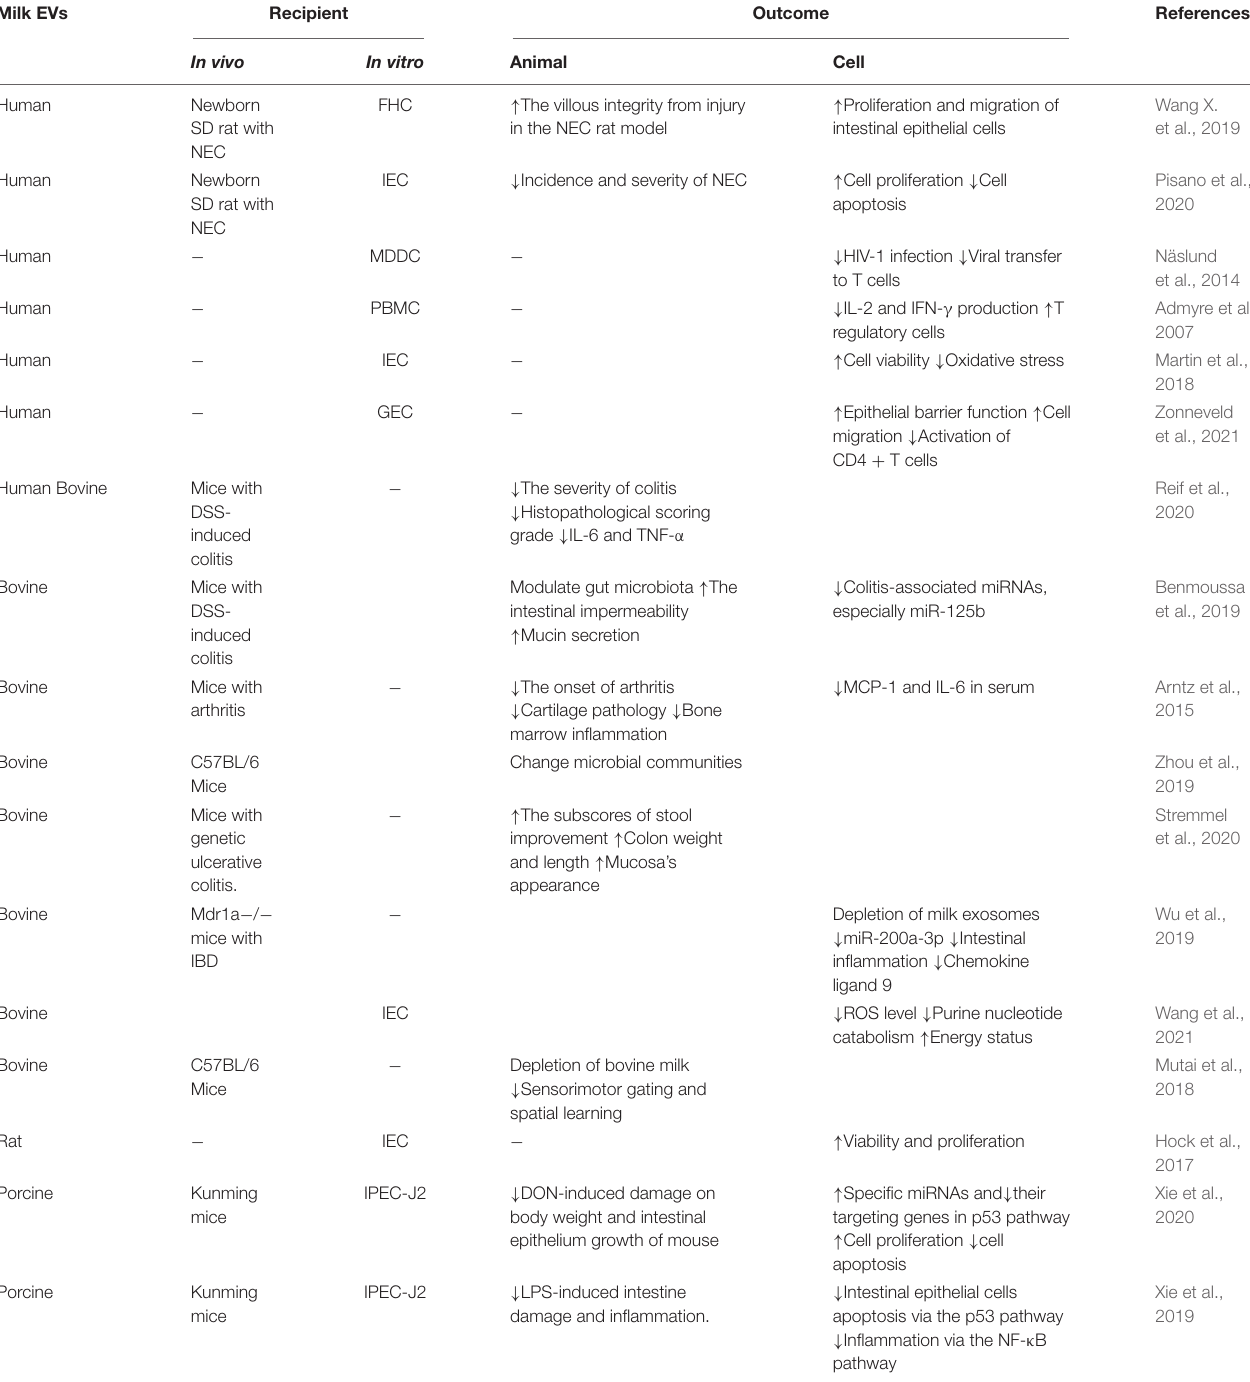
TABLE 2 | Summary of reports on milk-derived EVs and their bioactivities. Milk